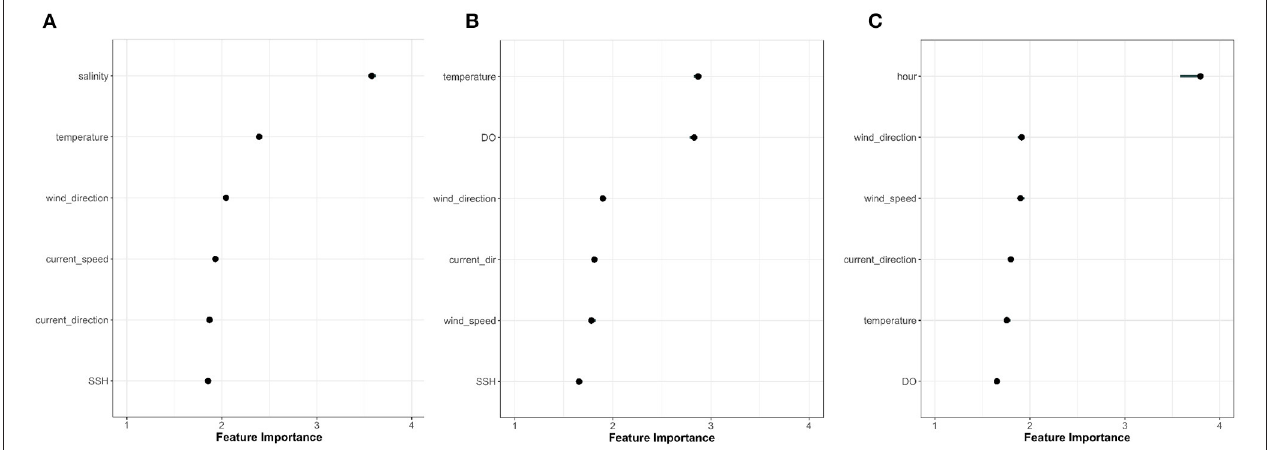
FIGURE 9 | Feature importance reported for our second experimental configuration “selected features” (section 2.3) at the (A) NOR, (B) SCO, and (C) CAN sites. The y -axis reports the ranked list of features that contributed the most to variation in fish depth measurements, while the x -axis presents relative magnitude of those